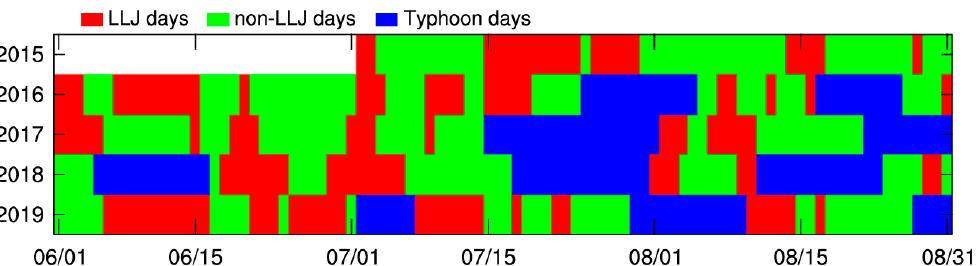
Figure 1. Sequence of daily changes on low-level jet (LLJ) days, non-LLJ days, and days characterized by the passage of a typhoon.